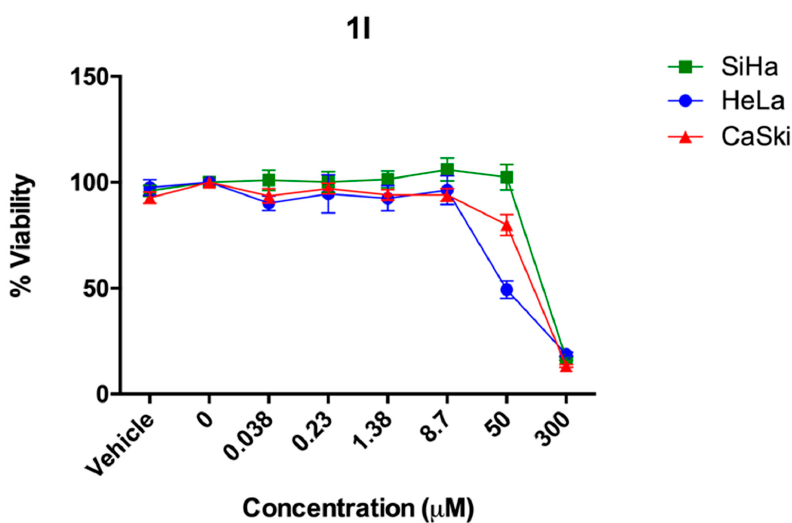
Figure 3. Cell viability of 1k on human cervical cancer cells SiHa, HeLa, and CaSki.